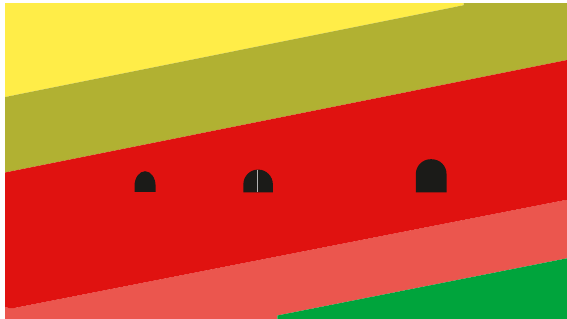
Figure 3: Numerical calculation model of the chamber sur- rounding